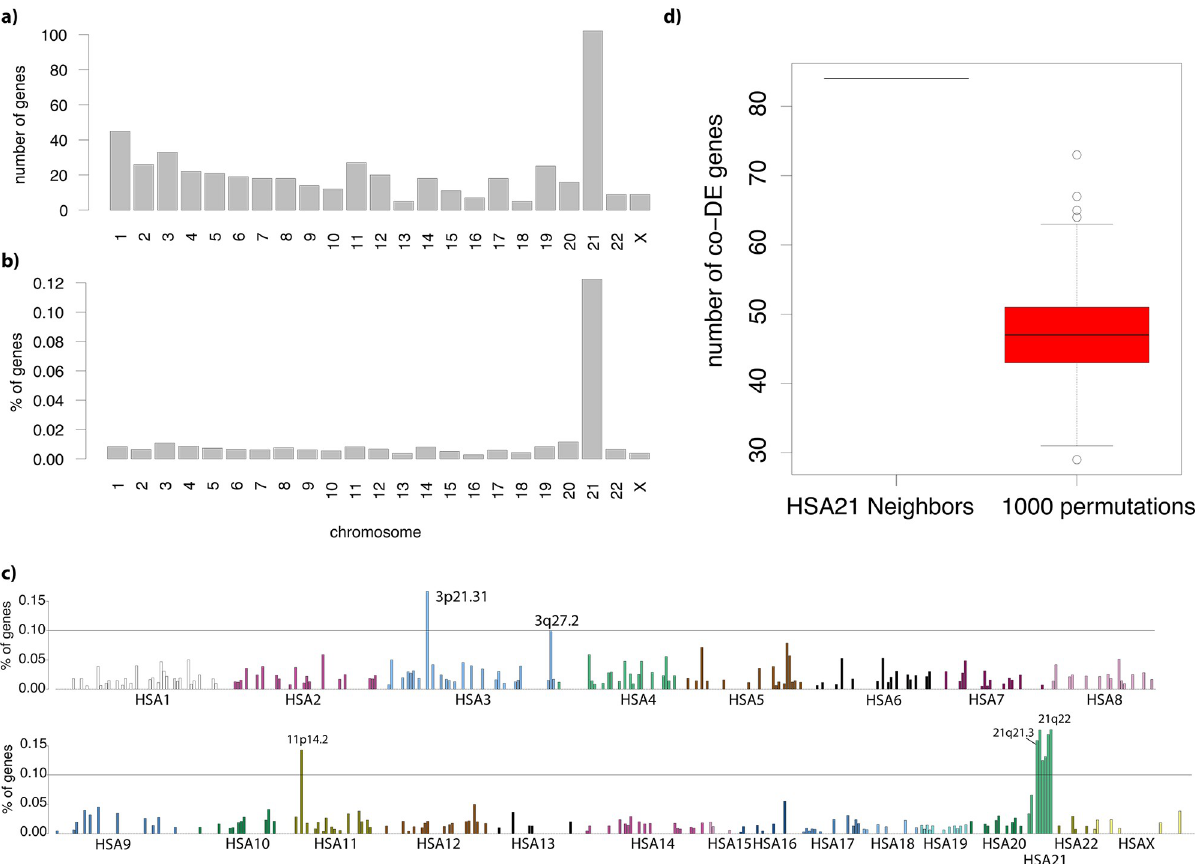
Fig 3. Most of the consistently DE genes map on HSA21. a) Barplot for the number of consistently DE genes per human chromosome. b) Same as in a) but normalized for the number of genes located in each chromosome. c) Same as in B but at the cytogenetic band resolution. d) Number of consistently DE genes that are HSA21 interactors (left). Boxplot of the number of consistently DE genes in 1000 random permutations (sampled with the same length as the total number of HSA21